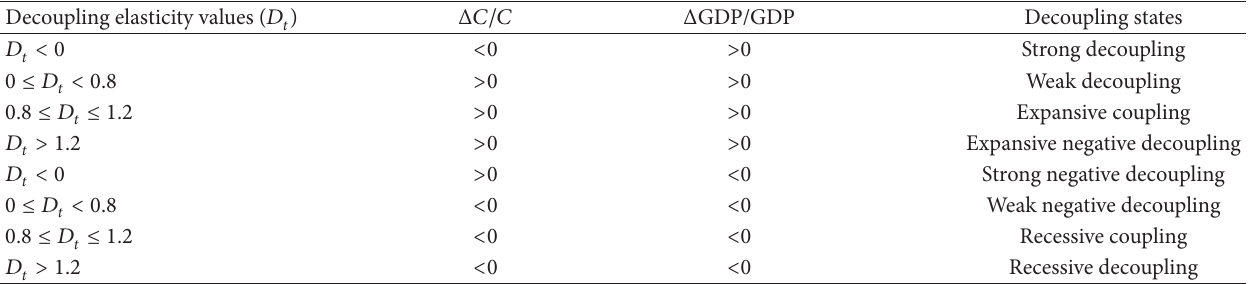
Table 2: Eight decoupling states divided by Tapio (2005)